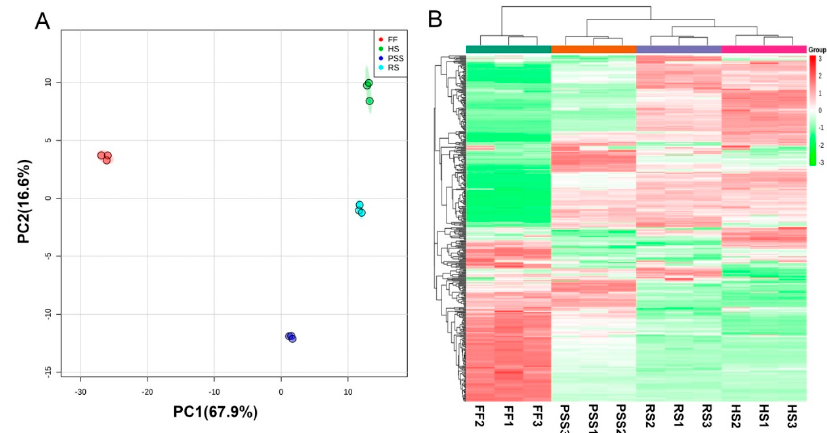
Figure 3. Score plot of principal components analysis (PCA) ( A ) and heatmap of hierarchical cluster analysis (HCA) ( B ) showing that the leaf development regulated E. Pubescens foliar metabolites. The abbreviated stage name and observation dates were the same as described in Figure 1. HS in metabolomic analysis referred to leaf samples collected on 27